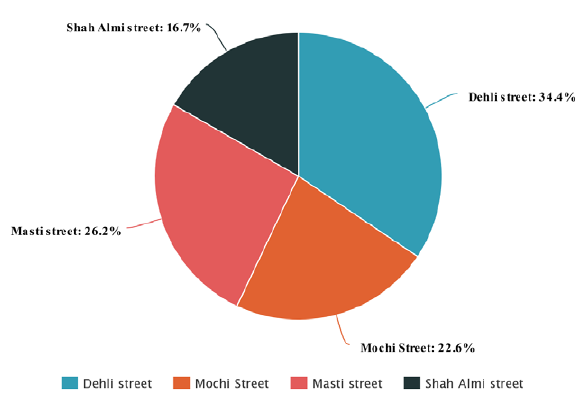
Figure 5. Place attachment from the selected four